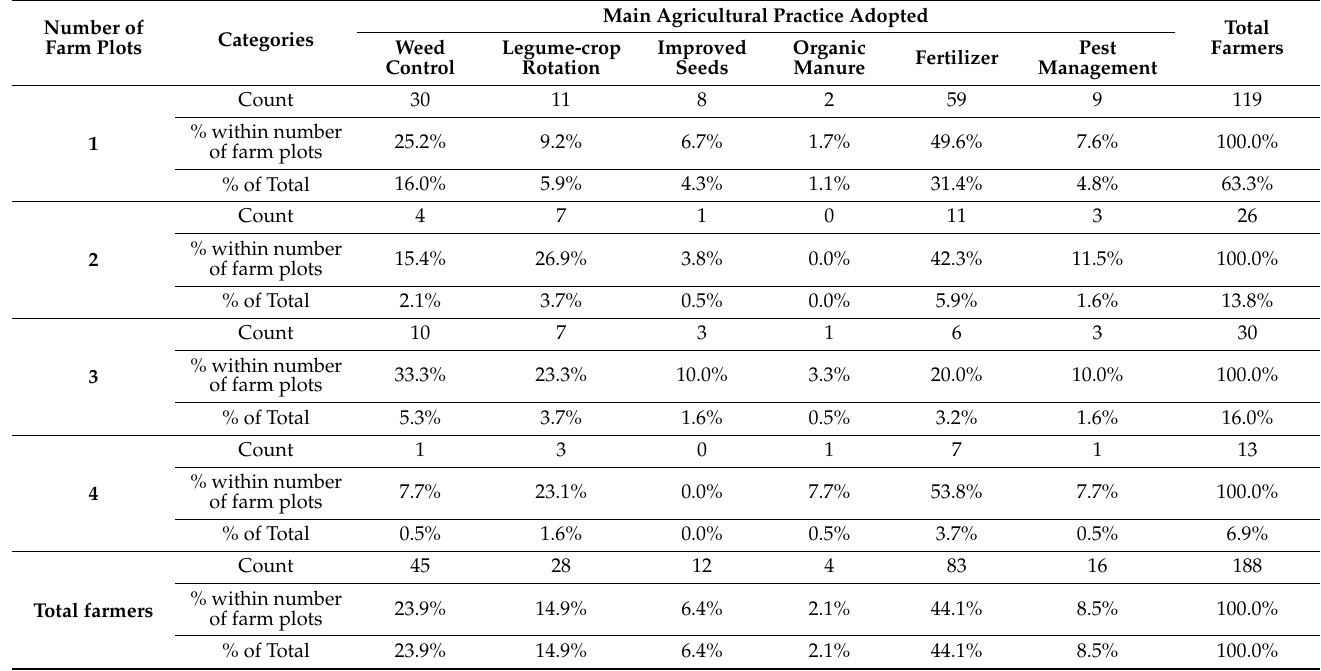
Table A3. Number of farm plots the farmers cultivate and main agricultural practice